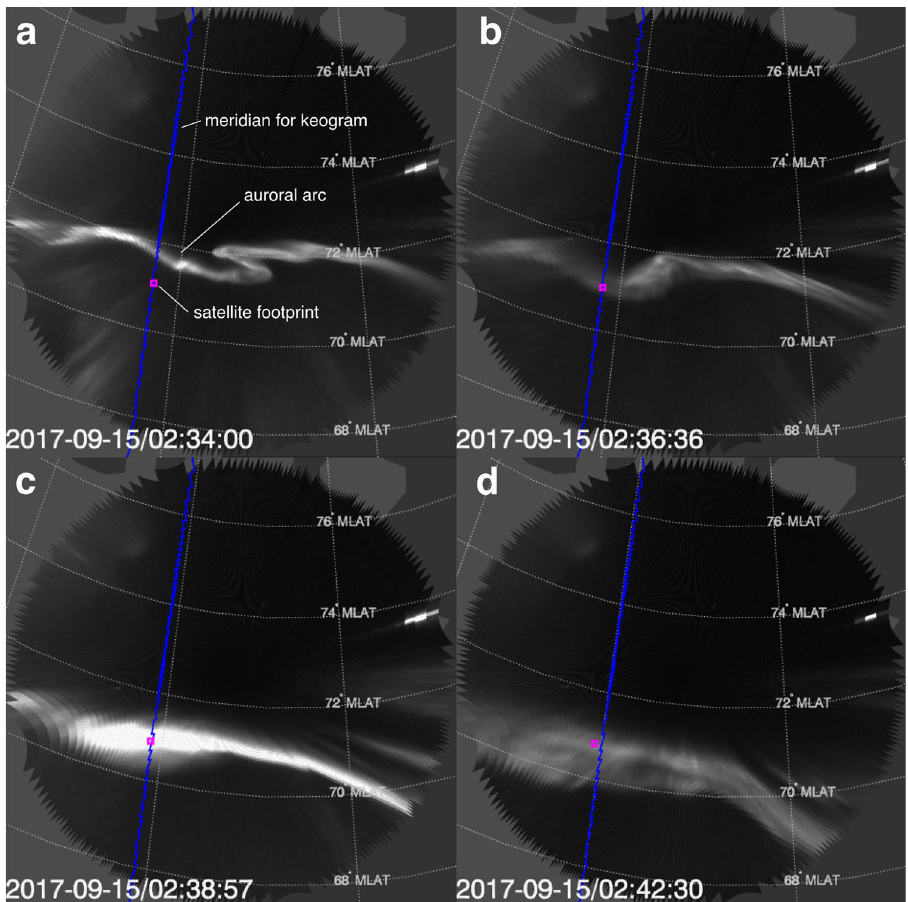
Figure 1. Images of the auroral arc around the footprint of Arase. The images were captured at 02:34:00– 02:42:30 UT on 15 September, 2017 by the all-sky camera at Rankin Inlet (RANK). The magenta square shows the ionospheric footprint of Arase determined by the Tsyganenko and Andreeva (TA) 15B model. The latitudinal grid shows the magnetic latitude in altitude-adjusted corrected geomagnetic coordinates. The blue line shows the meridian along which the south-to-north cross-sectional time series of auroral intensity were collected for Fig. 2. Supplementary Video S1 shows the full motion of the auroral arc at a 3-s